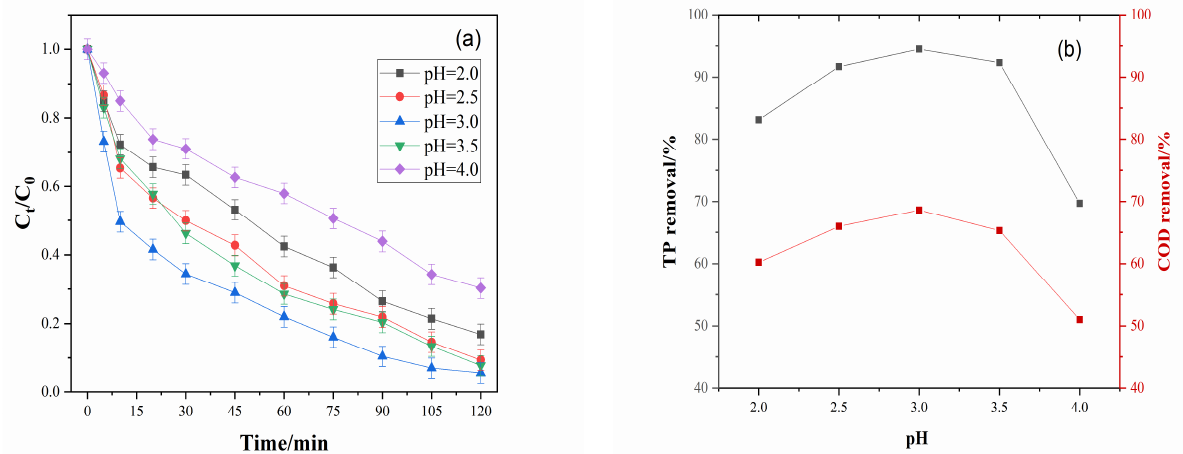
Figure 5. ( a ) Effect of pH on glyphosate removal; ( b ) Effect of pH on TP and COD removal (initial CaO 2 dosage = 0.5 g, the molar ratio of Ca 2+ :Fe 2+ = 6, 100 mL 50 ppm glyphosate solution, 150 rpm, RT = 25 °C, contact time = 120 min).